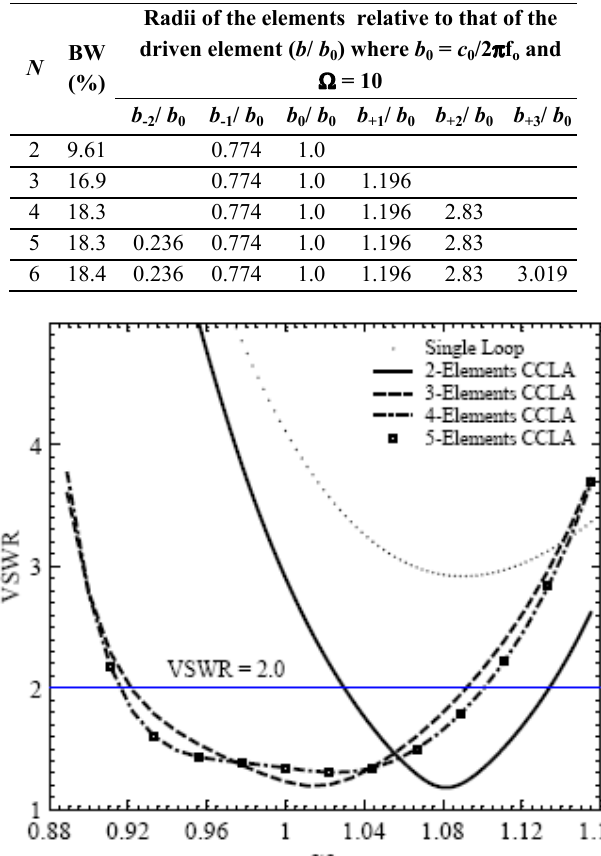
Table 1: Sizes of different CCLA for best bandwidths.